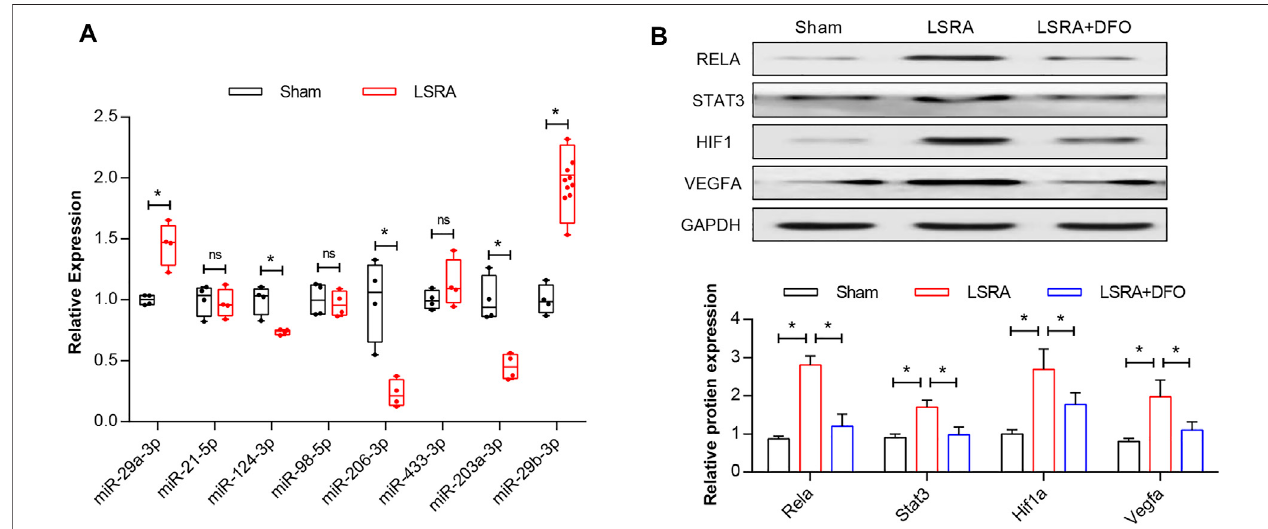
FIGURE 8 | Veri fi cation of key ferroptosis DEGs. (A) qRT-PCR analysis of predicted miRNAs. n = 10 rats/group; signi fi cance was calculated using the Student ’ s t -test, * p < 0.05. (B) Western blot analysis of Rela, Stat3, Hif1a, and Vegfa. n = 10 rats/group; signi fi cance was calculated using the one-way ANOVA with Tukey ’ s posthoc test, * p < 0.05. Abbreviations: DEGs, differentially expressed genes; Sham, sham-operated rats; LSRA, lumbosacral spinal root avulsion; and DFO,